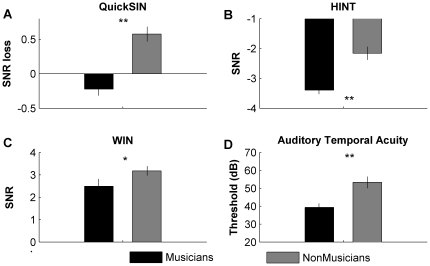
Performance for musicians and non-musicians on speech-in-noise and backward masking tasks.Musicians demonstrated enhanced performance for all three measures of speech-in-noise perception (QuickSIN, HINT and WIN), indicating that they were better able to hear in more challenging signal-to-noise ratios (SNRs). Musicians performed better (i.e., had lower thresholds) on the auditory temporal acuity test as assessed by backward masking. Error bars represent one standard error. * p<0.05 ** p<0.01.